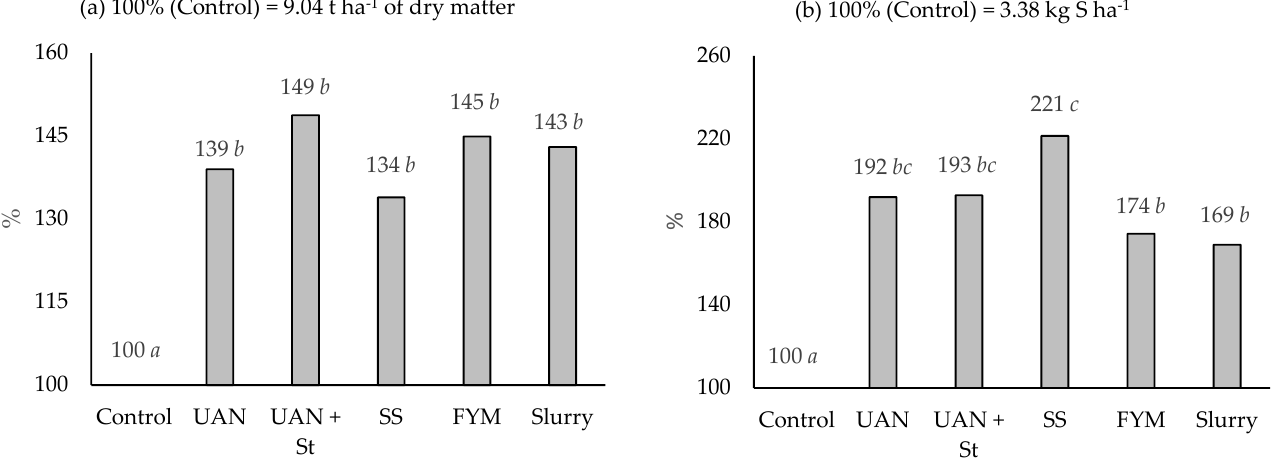
Figure 2. Relative average yields ( a ) and relative average sulfur uptake ( b ) at harvest during the period 1993-2019; the different italic letters describe statistically significant differences between treatments. Tukey HSD test; p < 0.05. n = 27 .